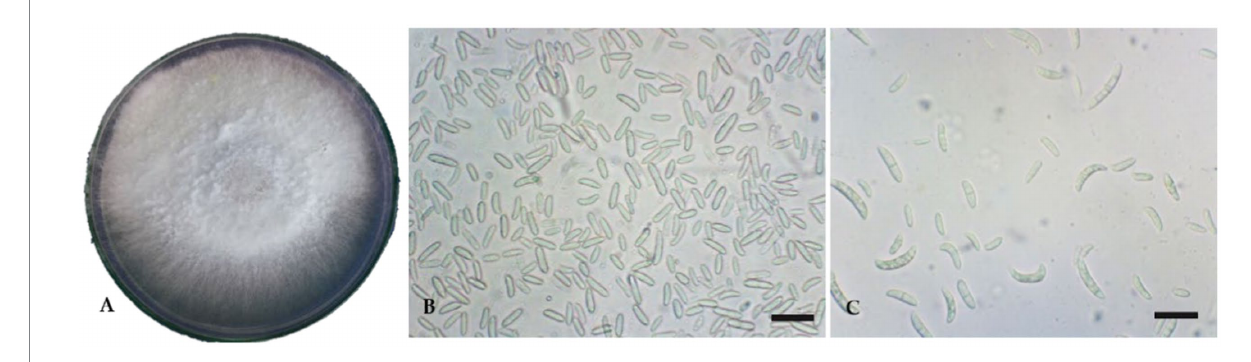
FIGURE 1 Cultural and micromorphological features of Fusarium oxysporum f. sp. lycopersici . Scale bars = 10 μ m. (A) Culture plate; (B) Microconidia; (C)